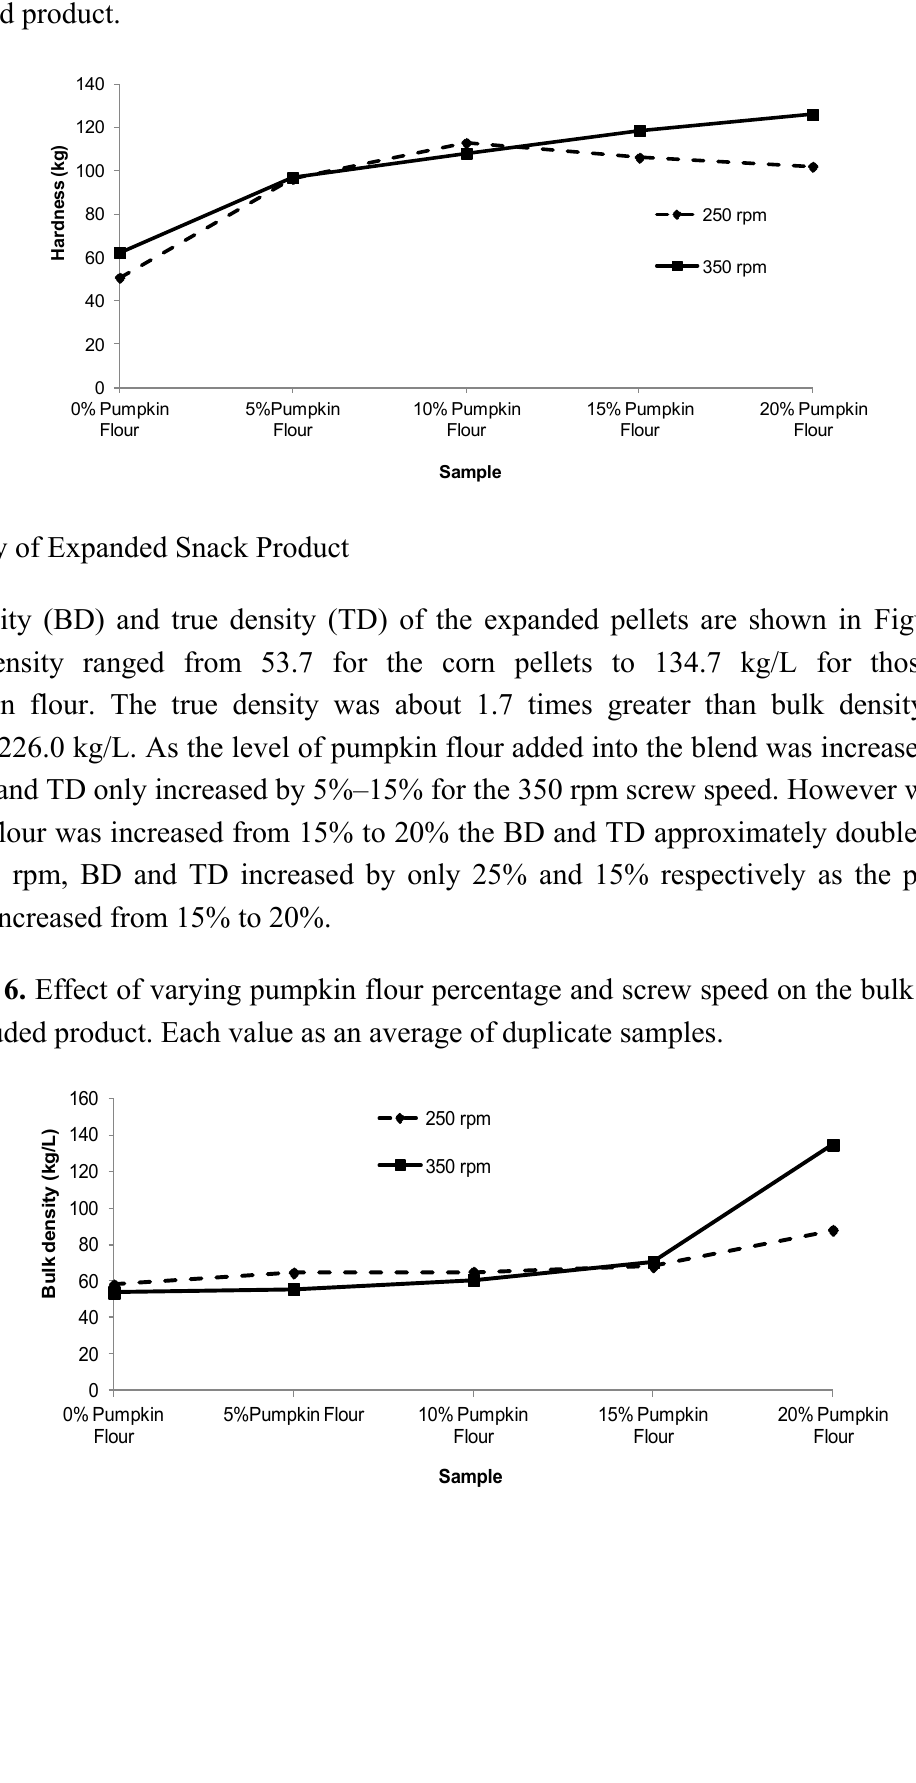
Figure 5. Effect of varying pumpkin flour percentage and screw speed on the hardness of extruded product.